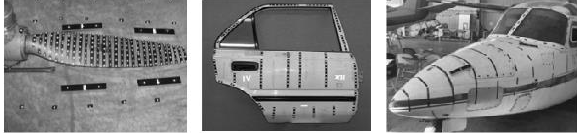
Figure 3. The investigated propeller, the car door, and the